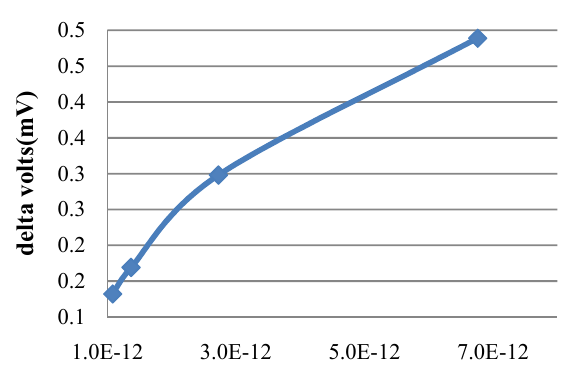
Figure 10. The relationship of the concentrations of the fluorescein solution samples and the voltage differences in pico-scale 10 × 10 − 12